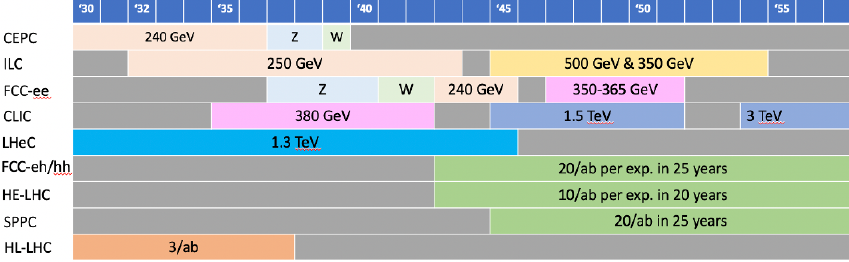
Figure 13 . Sketch of timeline of various collider projects starting at the \earliest start time" stated in the respective documents. For FCC-eh/hh this (cid:12)gure assumes that it is not preceeded by